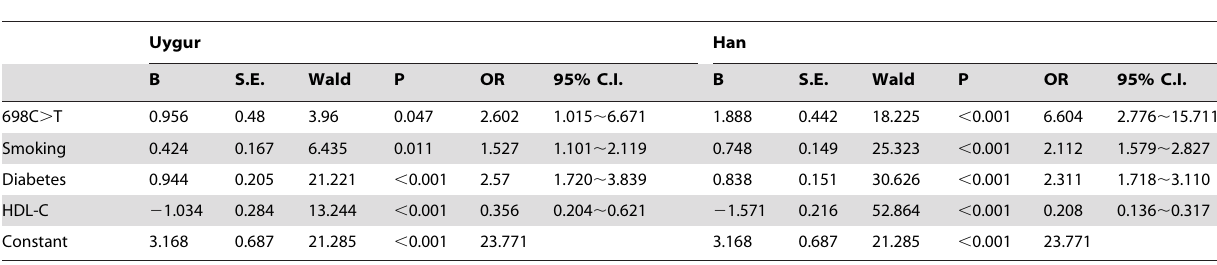
Table 3. Results of Logistic analysis.